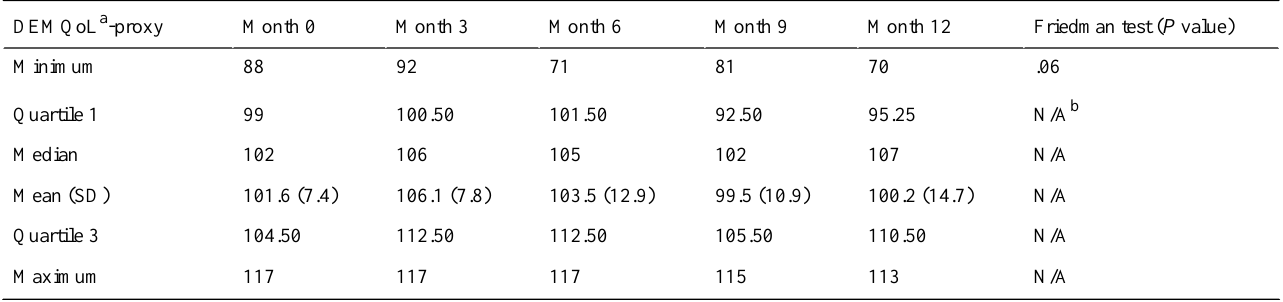
Table 10. Dementia Quality of Life-proxy score during the year